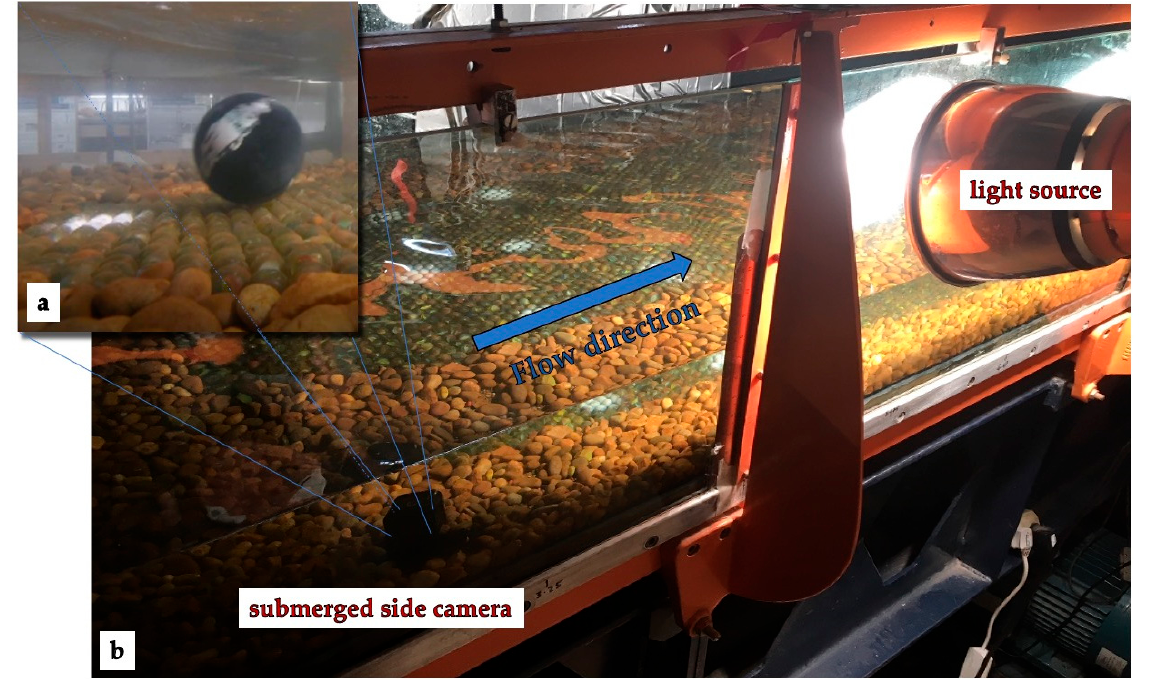
Figure 5. Demonstration of the experimental setup. ( a ) Top view of one of the beds roughnesses showing particle at rest. ( b ) Side view of one of the beds roughnesses showing the particle at motion phase.